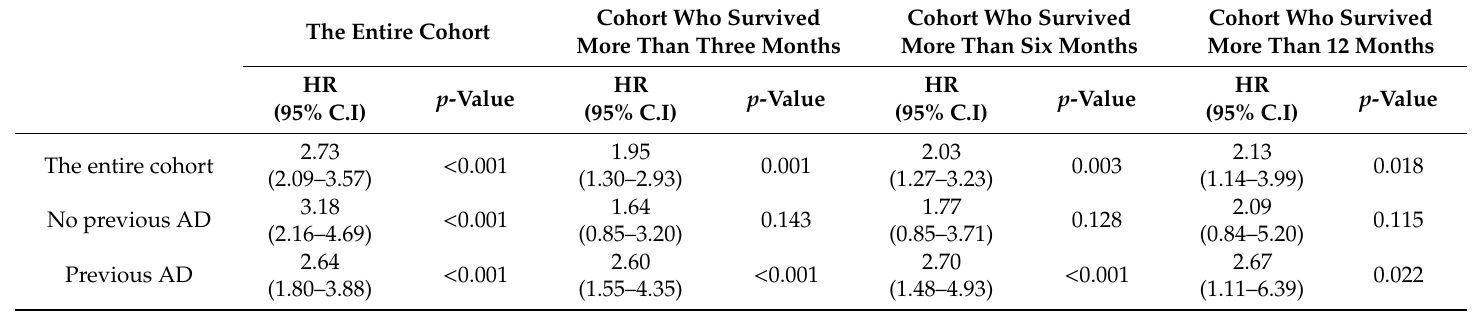
Table 4. Relative risks of severe AH experience (group 3) compared with the risks in groups 1 & 2 in various subgroups according to survival and the presence of previous AD